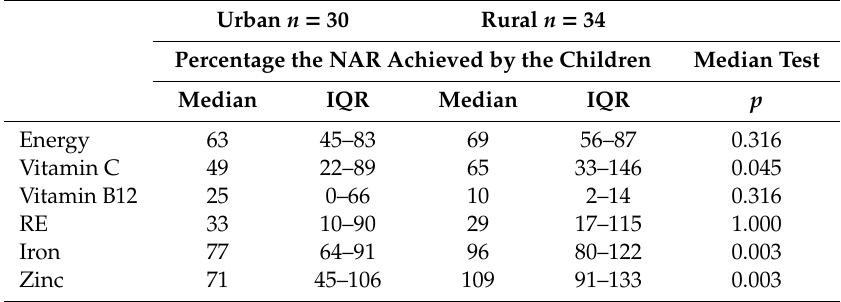
Table 7. Median and IQR of adequacy ratio of energy and nutrient intake of schoolchildren in